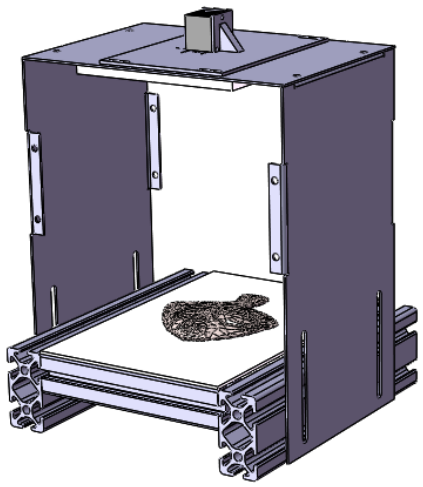
Figure 1. The device for image acquisition.